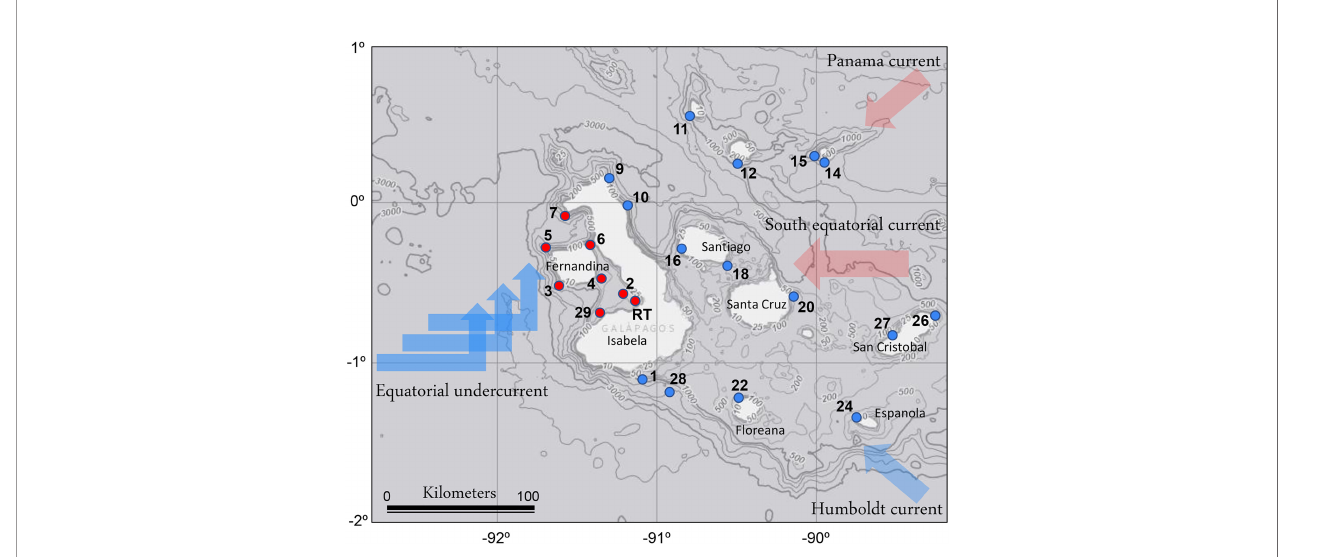
FIGURE 1 | Locations of sampling sites in the Gala ́ pagos Archipelago. The major oceanographic currents bringing primarily cold (blue) and warm (pink) waters to the region are indicated. Red circles indicate the Equatorial undercurrent upwelling (EUC) sites, and blue circles indicate the eastern region sites. The map is overlayed on NOAA bathymetry (https://maps.ngdc.noaa.gov/viewers/bathymetry/). RT indicates the red tide bloom